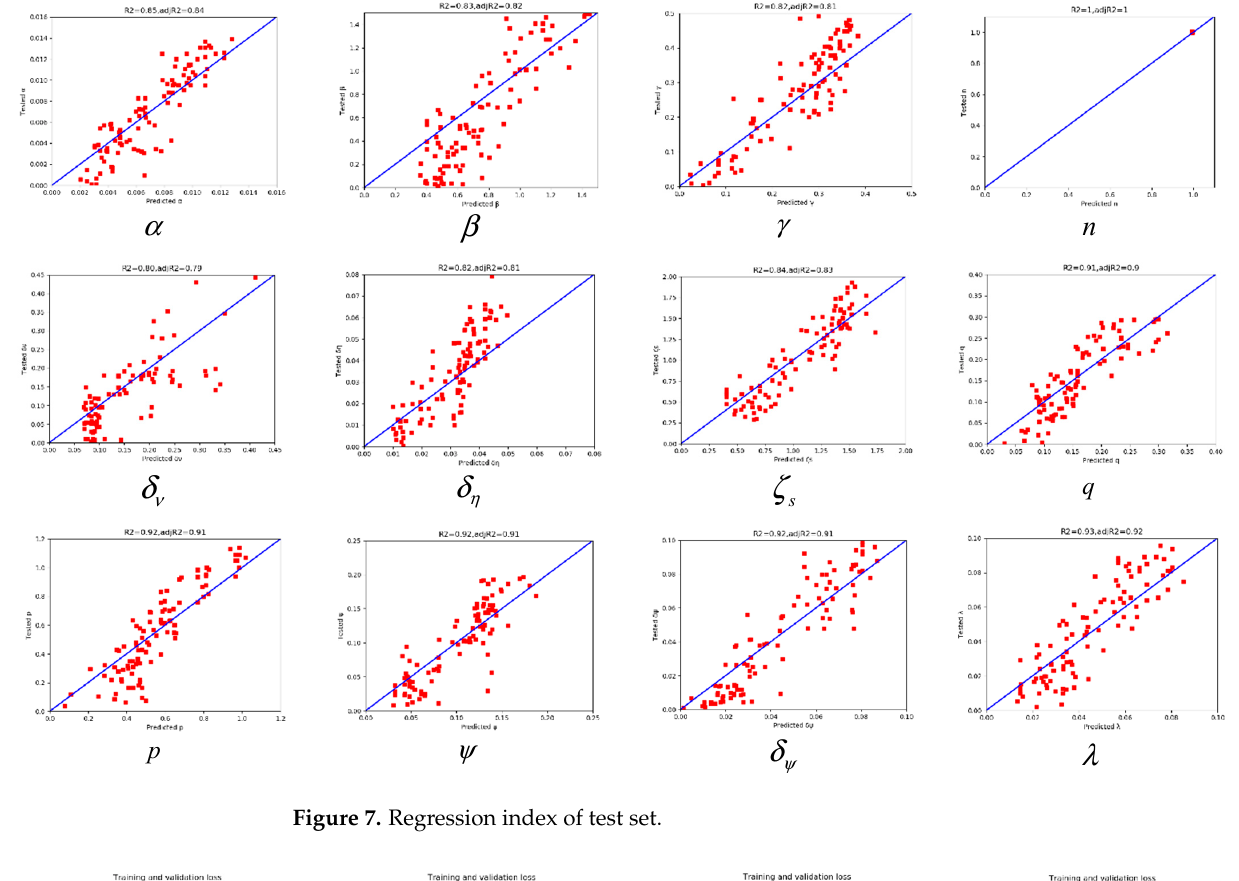
Figure 7. Regression index of test set.